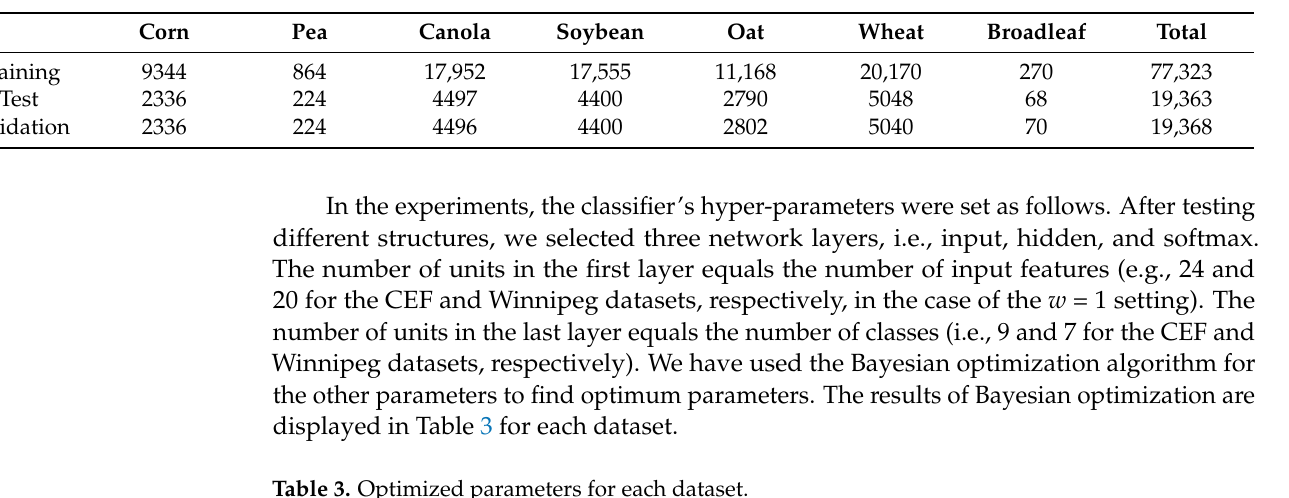
Table 2. The number of training, test, and validation samples in each class for the Winnipeg dataset.